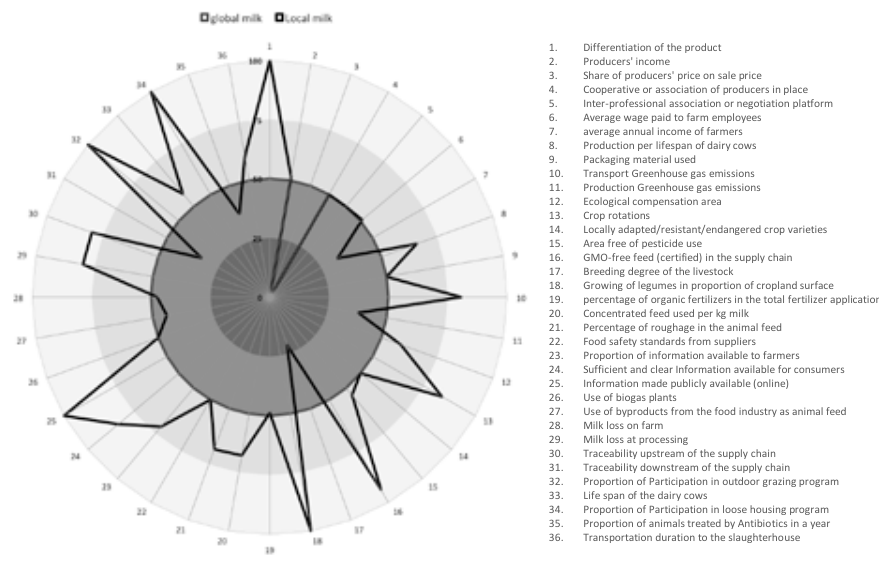
1. Differentiation of the product